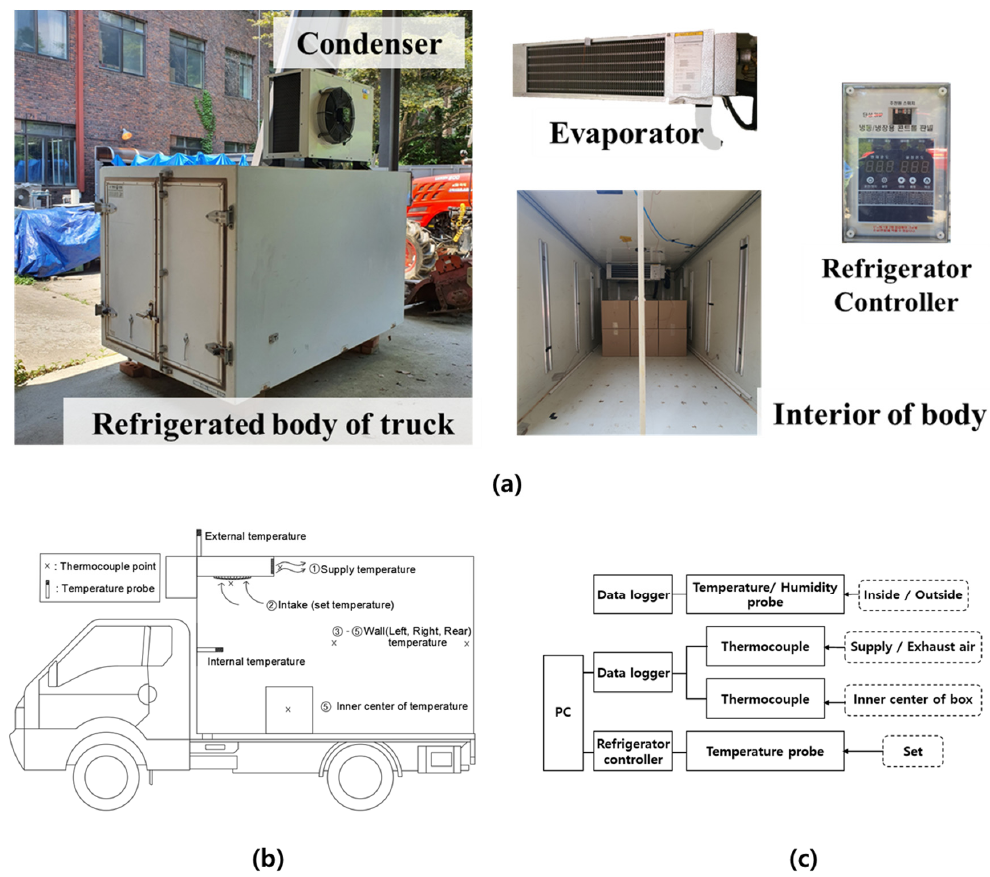
Figure 1. ( a ) Configuration and appearance of the refrigeration system ( b ) Installation position of temperature sensor ( c ) Configuration diagram of sensor and device .